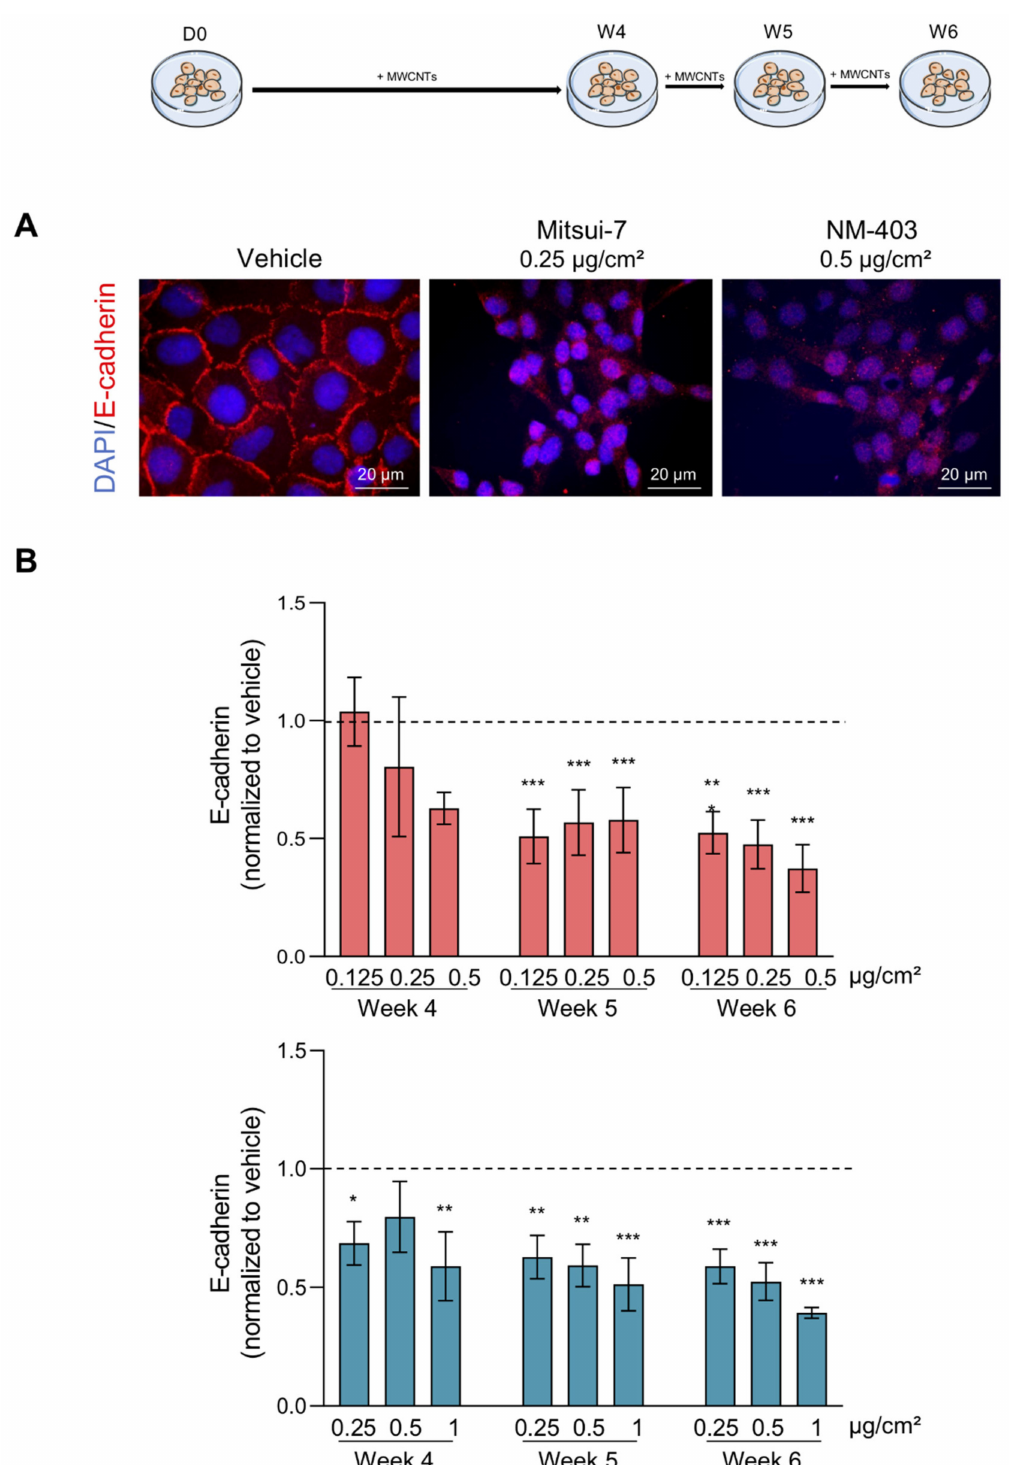
Figure 8. MWCNTs reduced E-cadherin in BEAS-2B cells. ( A ) The cells were treated with vehicle, 0.25 µ g/cm 2 of Mitsui-7 or 0.5 µ g/cm 2 of NM-403 for 6 weeks. The cells were immunolabeled with an anti-E-cadherin antibody and the nuclei were stained with DAPI. ( B ) Cells treated with the indicated concentrations of Mitsui-7 or NM-403 for 4 to 6 weeks were labeled with the anti-E-cadherin antibody and analysed using flow cytometry. The extracellular marker E-cadherin was quantified in the population of small cells and the bar graph represents the ratio of mean fluorescence intensity/total number of cells reported in the vehicle. The histograms represent the mean ± standard error of the mean (SEM) for three independent experiments. * p < 0.05, ** p < 0.01, *** p < 0.001 significantly different from the